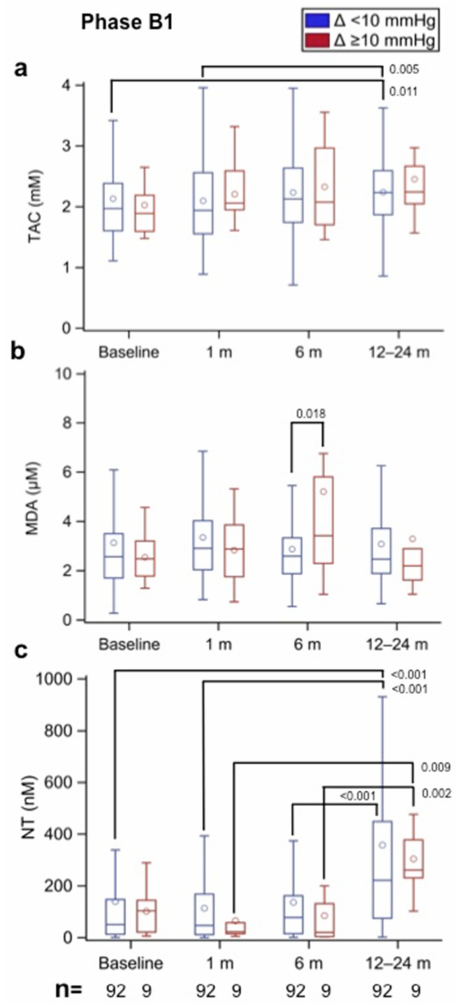
Figure 4. ( a ) Total antioxidant capacity (TAC, in mm), ( b ) malondialdehyde (MDA, in µ m), and ( c ) nitrotyrosine (NT, in nm) values in Phase B1 patients with implanted aortic biological prostheses at different time points according to the observed increment ( ∆ ) in the mean aortic prosthesis gradient ( ∆ < 10 mmHg—without incipient SVD, and ∆ ≥ 10 mmHg—with incipient SVD) between the 6- and the 12- to 24-month follow-ups. Therefore, each patient acted as his or her own control (e.g., paired results). The numbers within the figures represent the p -values, and the numbers at the bottom of the figures represent the number of assessed patients. Multiple comparison adjustments were performed with Dunnett’s and Tukey–Kramer’s